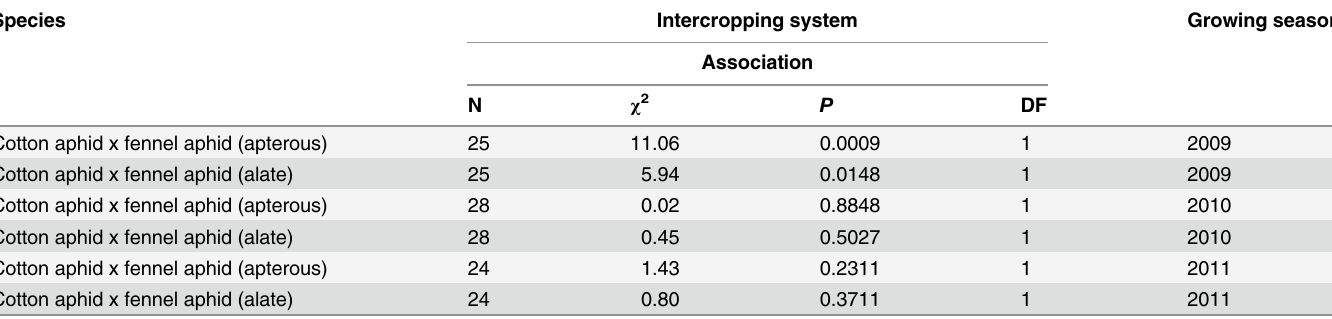
Table 3. Independence of H . foeniculi (apterous or alate) and A . gossypii (apterous or alate) in the intercropping systems.